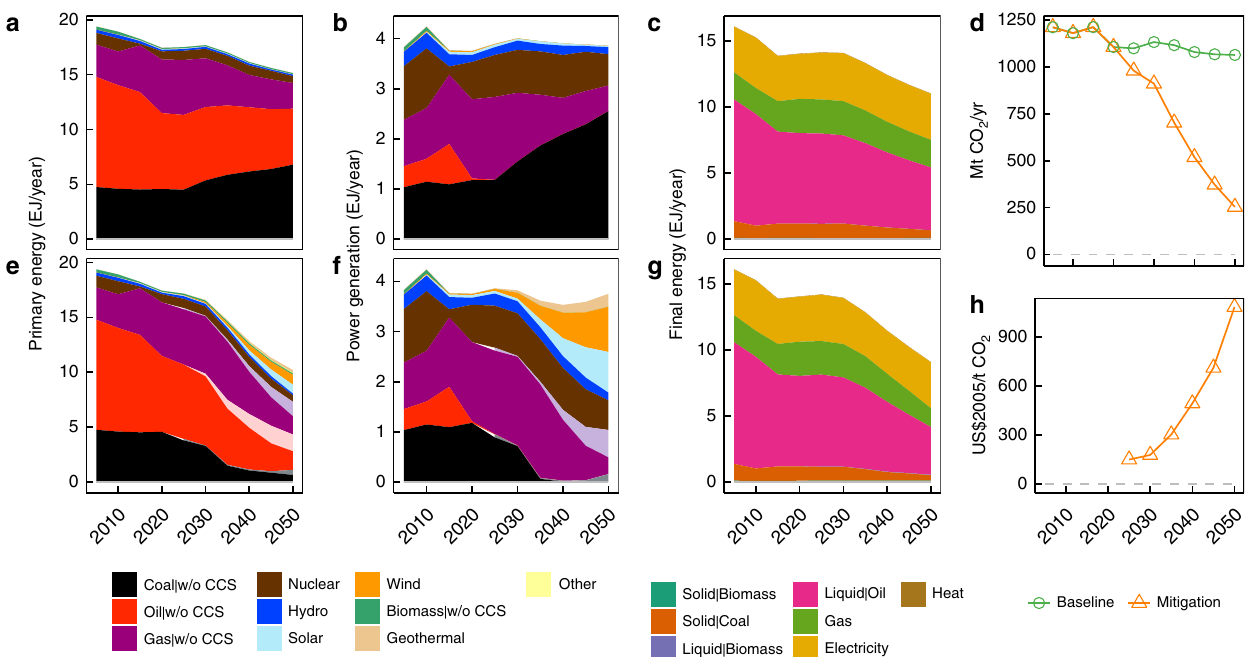
Fig. 1 Main energy and emissions related variables. Primary energy source ( a , e ), power generation ( b , f ), fi nal energy demand ( c , g ), CO 2 emissions ( d ), and carbon price ( h ) projections. a , b , and c show the baseline scenario, whereas e , f , and g show mitigation scenarios. The other in a and e